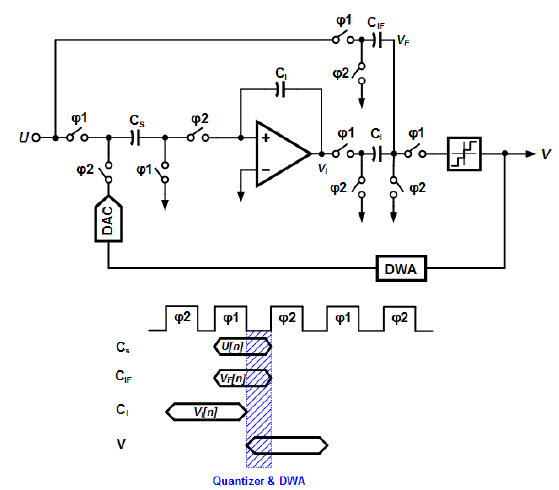
Figure 2. Conventional first-order switched capacitor circuit and its timing diagram [1].